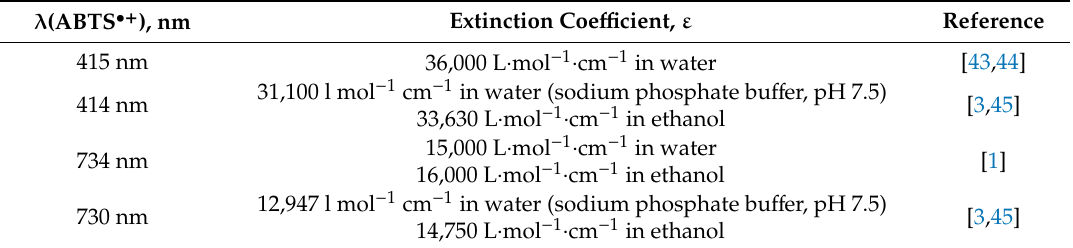
Table 2. The comparison of ABTS •+ UV ‐ VIS spectra characteristics.